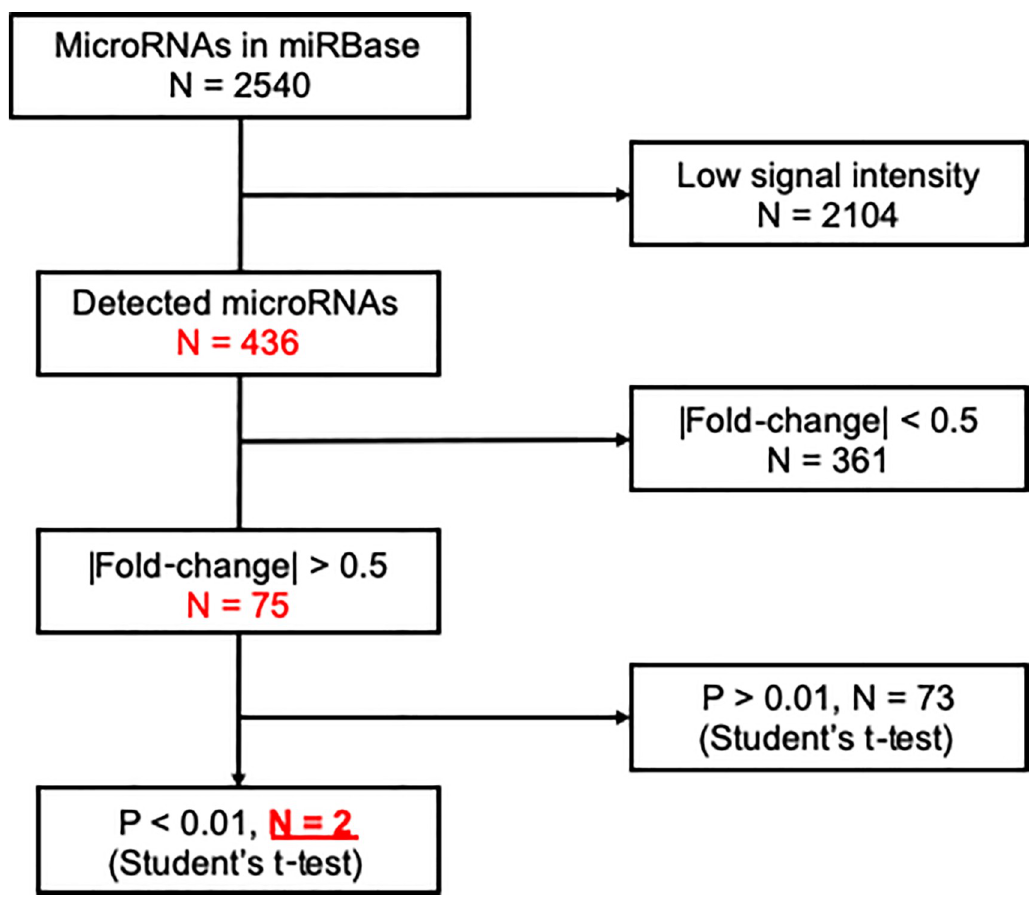
Fig 2. Flow diagram for detection of